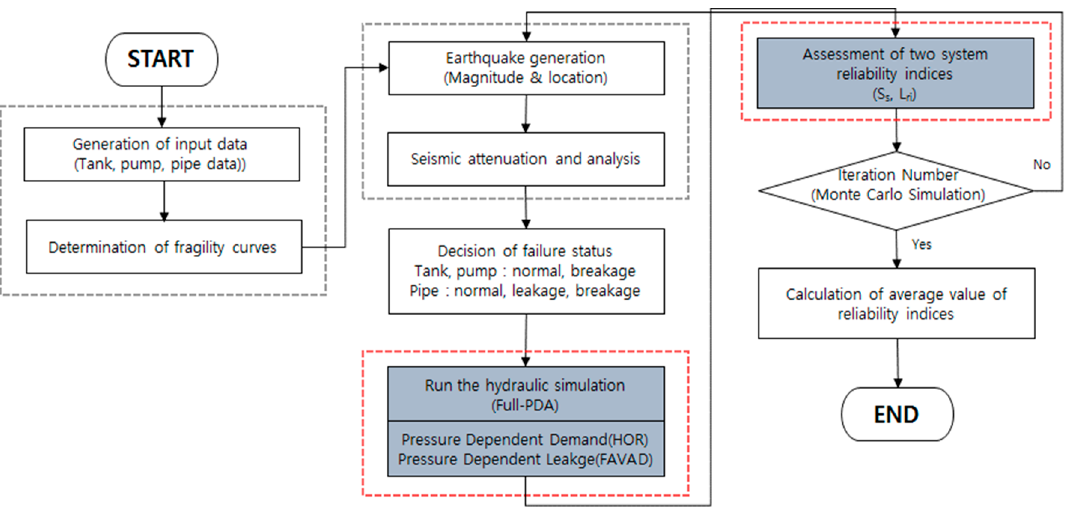
Figure 3. Proposed model running procedure.